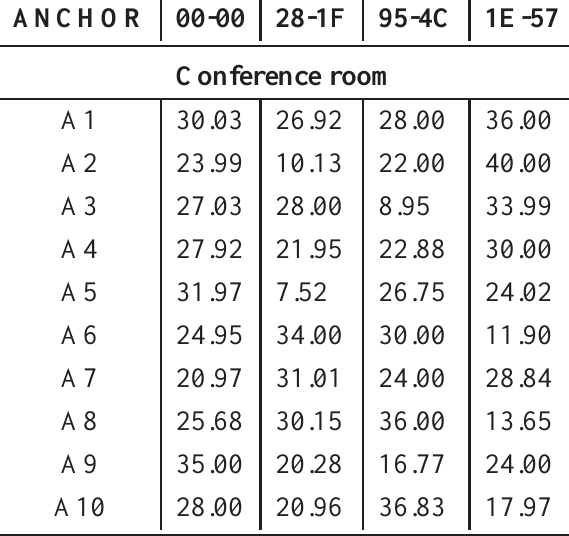
Table 2. Average values of the RSSI measurements for the three